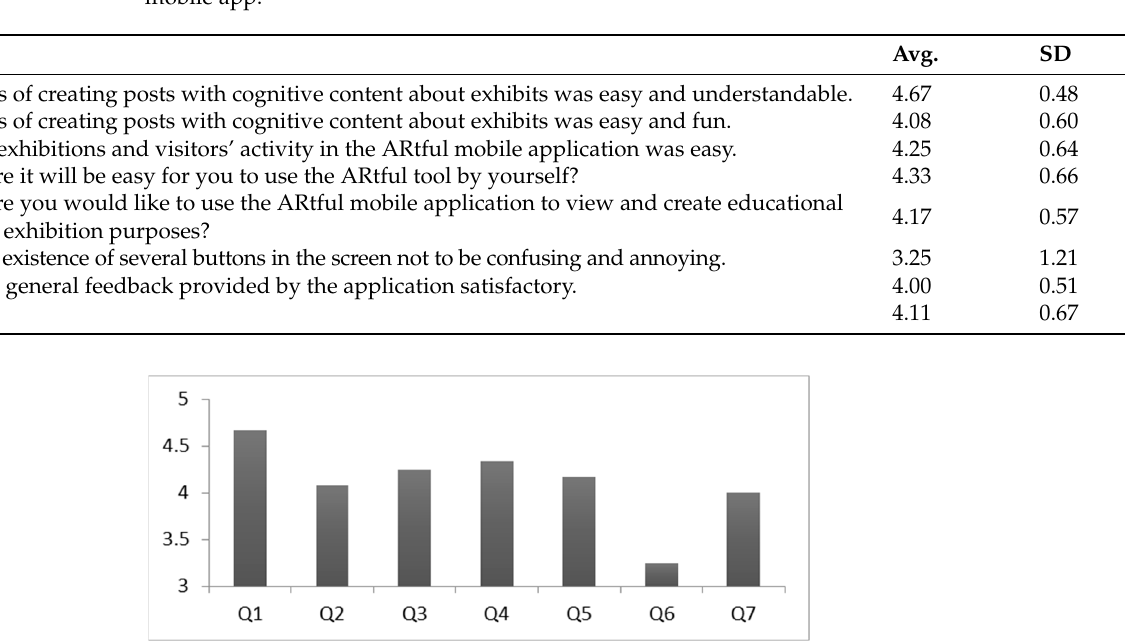
Table 6. Questions and average ratings of participants’ attitude concerning the usability of the ARtful mobile app.